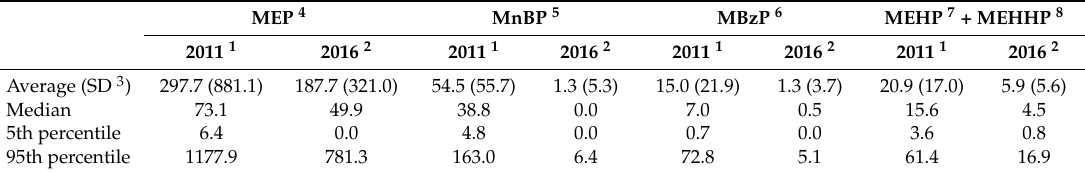
Table 5. Results of urine analysis of women ( µ g/g creatinine).